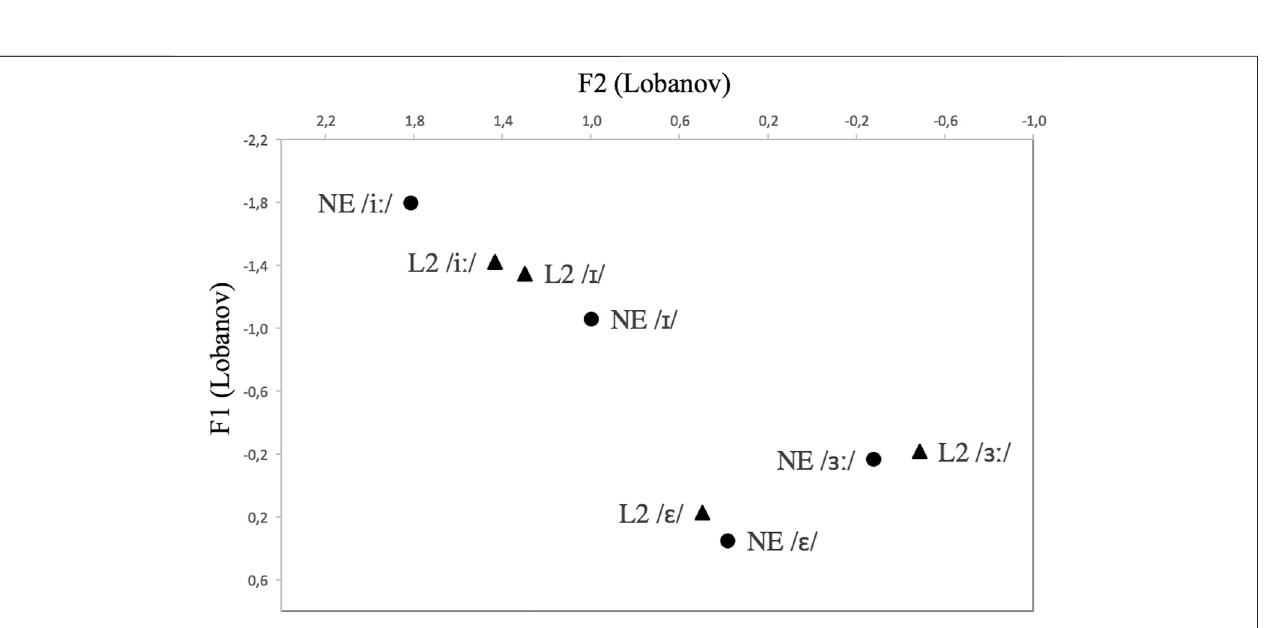
Frontiers in Communication |